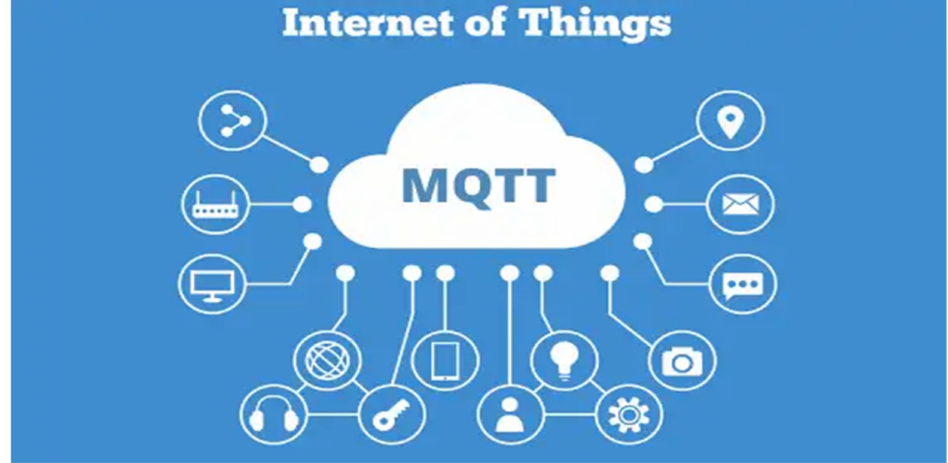
Figure 2. Connecting the MQTT protocol with IoT applications